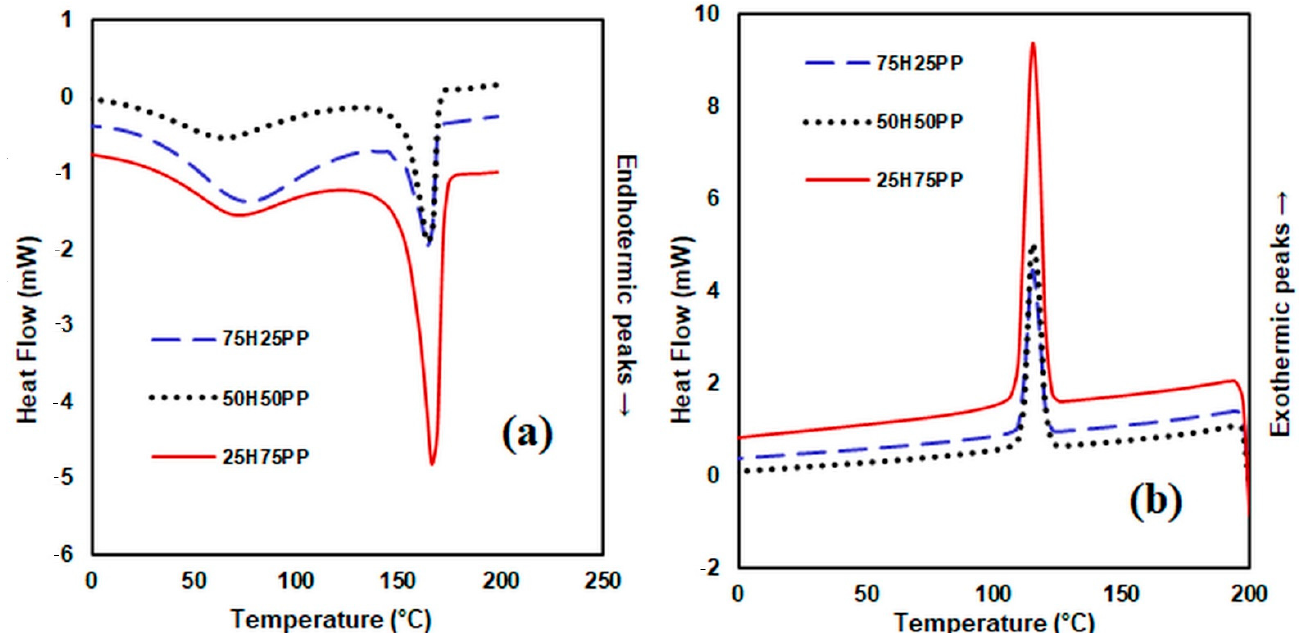
Figure 9. DSC curves heating process ( a ) and DSC curves cooling process ( b ) for the composite materials consisting of hemp fibres and polypropylene matrix.